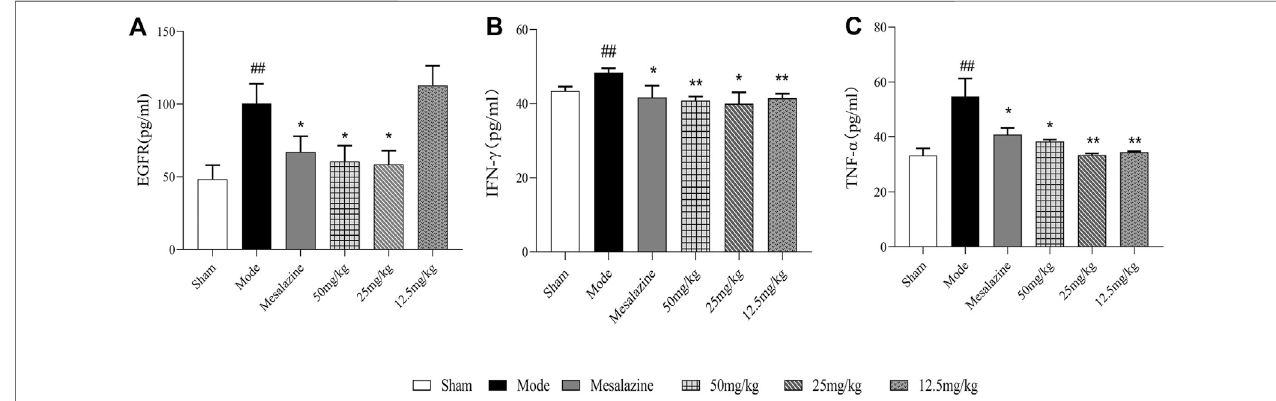
FIGURE6| Effects oflavender essentialoil onEGFR, IFN- γ , andTNF- α levelsinserum ofmodelmouse # p < 0.05vs.controlgroupand * p < 0.05vs. modelgroup.